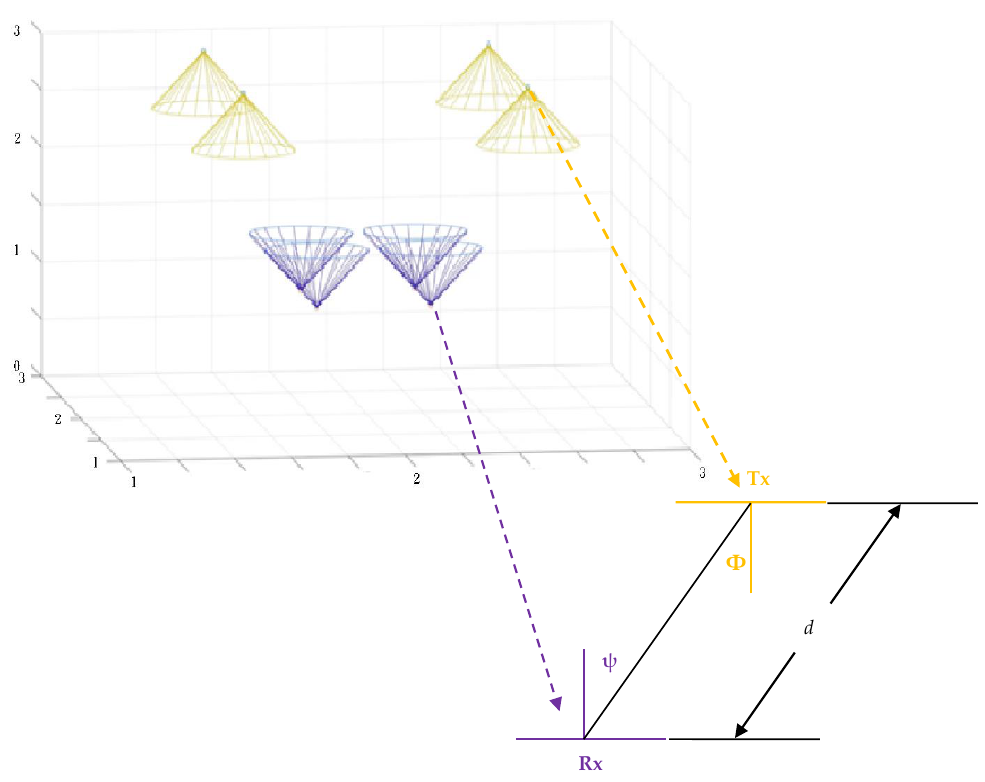
Figure 4. Geometric scenario (transmitters in yellow and receivers in purple) used to detect the channel response.